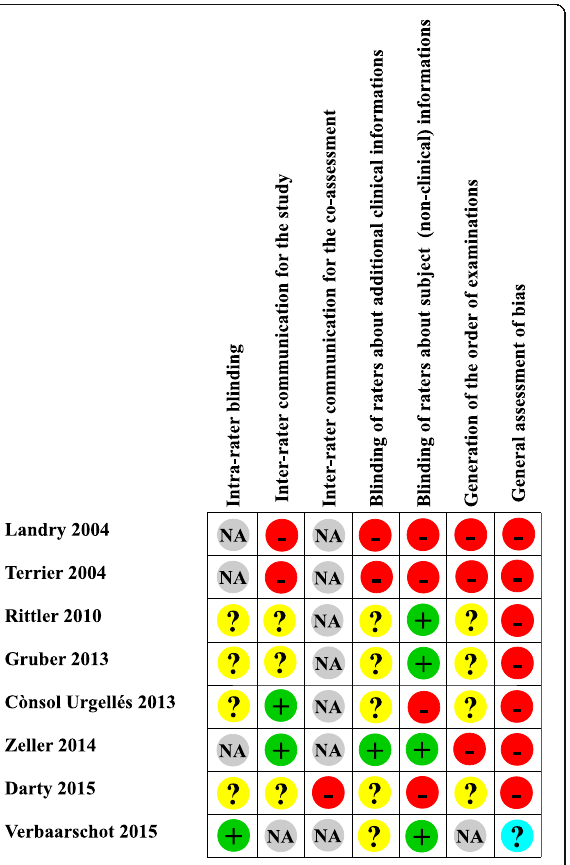
Fig. 2 Assessment of methodological risk of bias for each reliability studies included. Green shading indicates a low risk of bias, yellow an unclear risk of bias and red a high risk. Grey shading color indicates non-applicable items. For general assessment of bias, purple shading and cyan shading indicates a major doubt and a minor doubt as to the overall risk of bias,